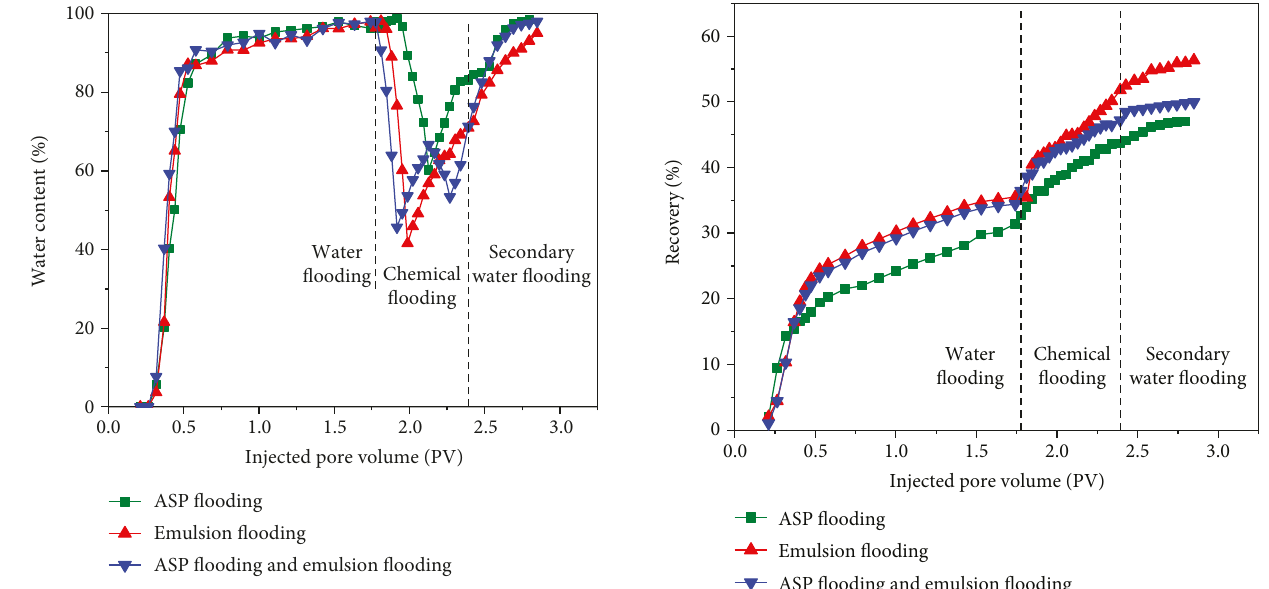
Figure 13: Water content variation curve of di ff erent chemical fl ooding.